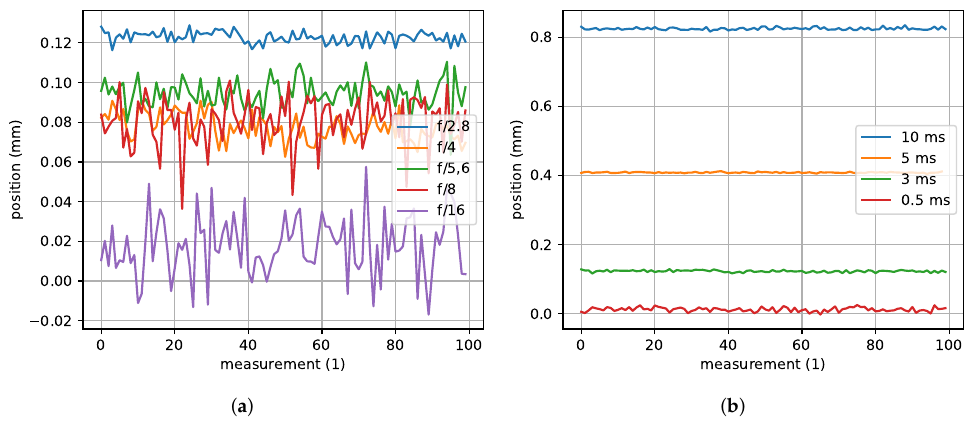
Figure 13. Influence of the illumination on the pose estimate in z -direction: ( a ) constant exposure time of 3 ms with variable aperture stops and ( b ) constant aperture stop f/8 with variable exposure